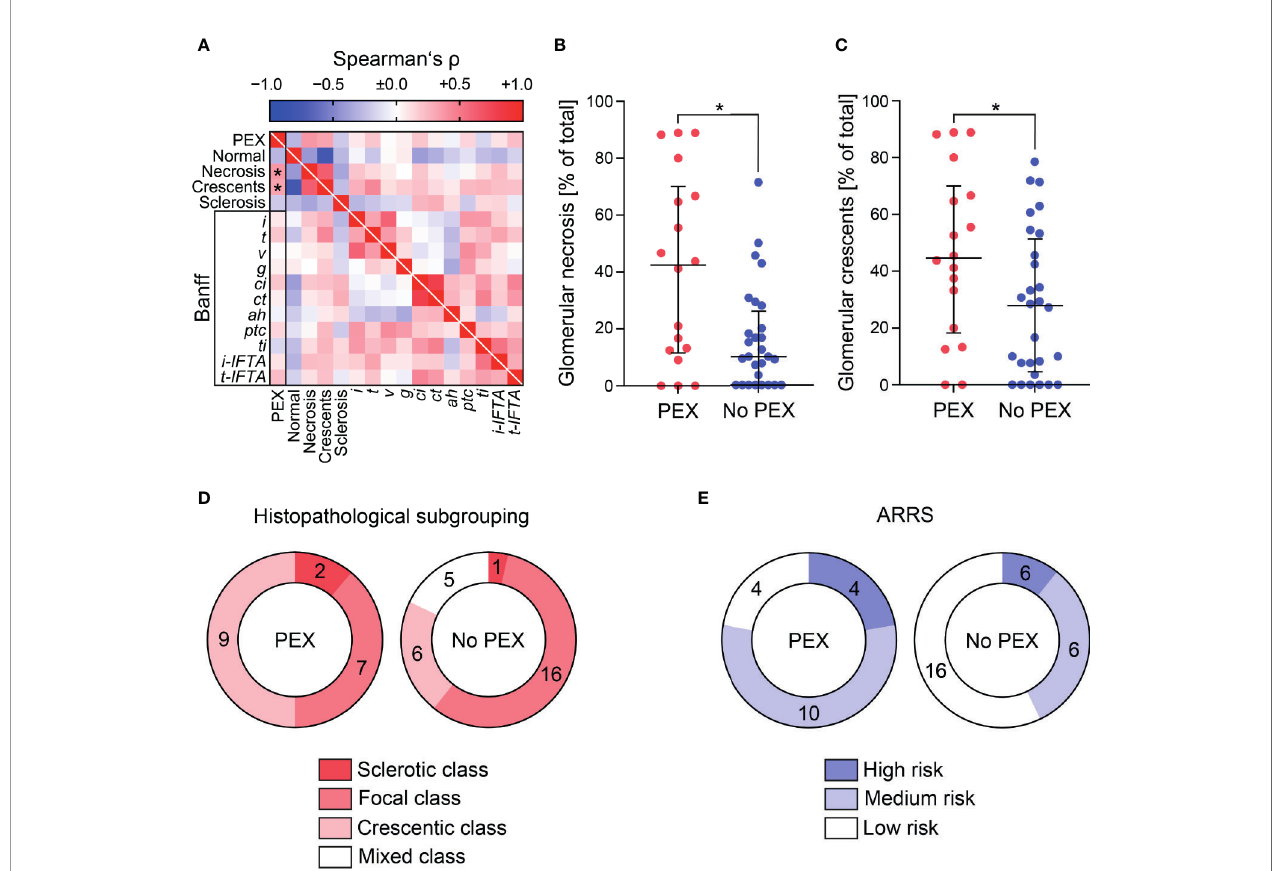
FIGURE 3 | Renal histopathological fi ndings in association with PEX for treatment of severe AAV. (A) Association between initiation of PEX treatment and renal histopathological fi ndings are shown by heatmap re fl ecting mean values of Spearman ’ s r , asterisks indicate p <0.05 . (B, C) The scatter dot plots represent medians and IQR with individual data points summarizing association between initiation of PEX treatment and indicated histopathological fi ndings, Mann-Whitney U-test was used to determine differences in medians and asterisks indicate p <0.05 . (D, E) Association between initiation of PEX treatment, histopathological subgrouping and ARRS are shown. AAV, ANCA-associated vasculitis; ah , arteriolar hyalinosis; ARRS, ANCA renal risk score; ci , interstitial fi brosis; ct , tubular atrophy; g , glomerulitis; GN, glomerulonephritis; i , interstitial in fl ammation; i-IFTA , in fl ammation in IFTA; IQR, interquartile range; PEX, therapeutic plasma exchange; t , tubulitis; ptc , peritubular capillaritis; ti , total in fl ammation; t-IFTA , tubulitis in IFTA; v , intimal